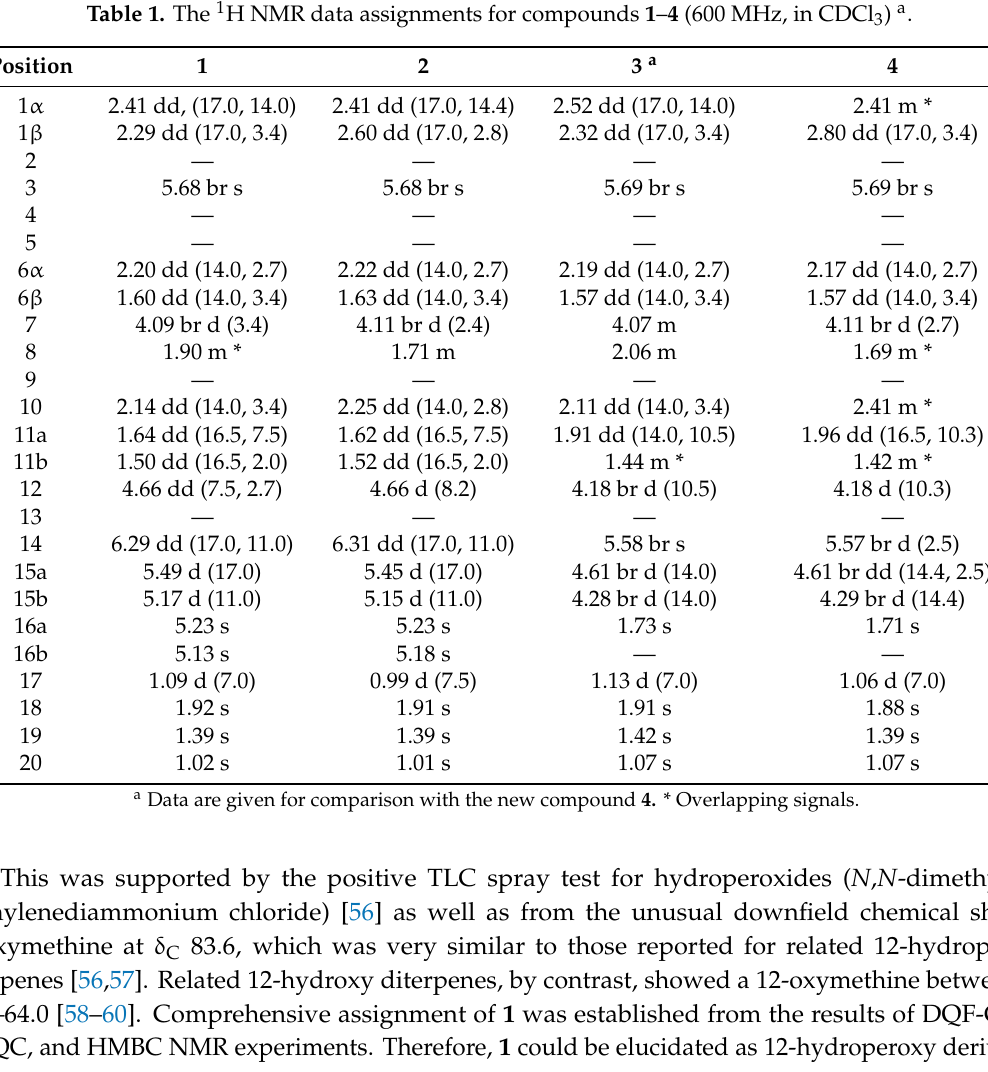
Table 1. The 1 H NMR data assignments for compounds 1 – 4 (600 MHz, in CDCl 3 ) a .